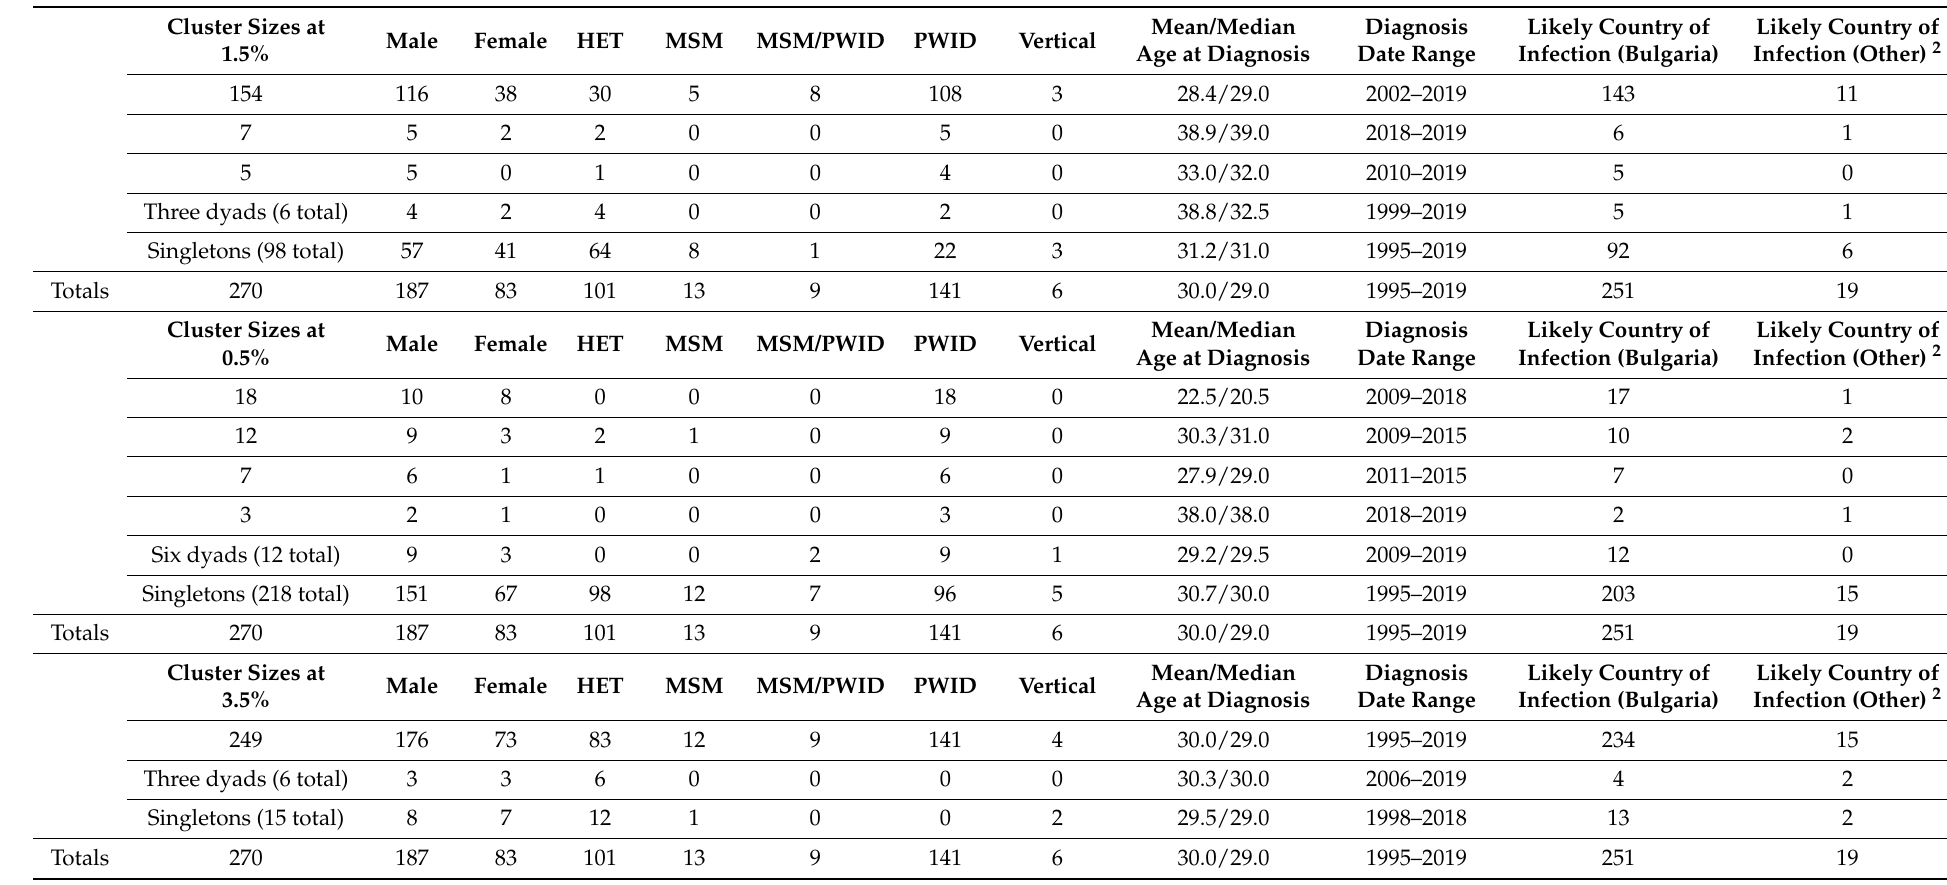
Table 3. Characteristics of HIV-1 subtype CRF01_AE clusters and unclustered persons in Bulgaria, 1995–2019, using genetic distance cutoffs of 1.5%, 0.5%, and 3.5% 1 . Cluster Sizes